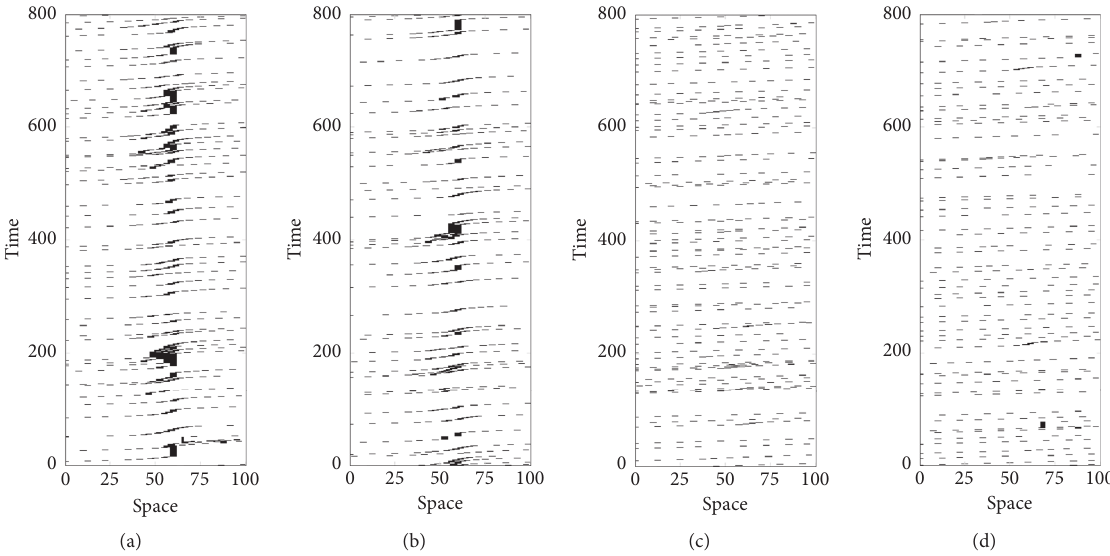
Figure 9: Space-time diagrams of free flow vehicles under different driving behaviors ( α v � 0.1, α b � 0.1). (a) β v � 0.9. (c) β v β v 2